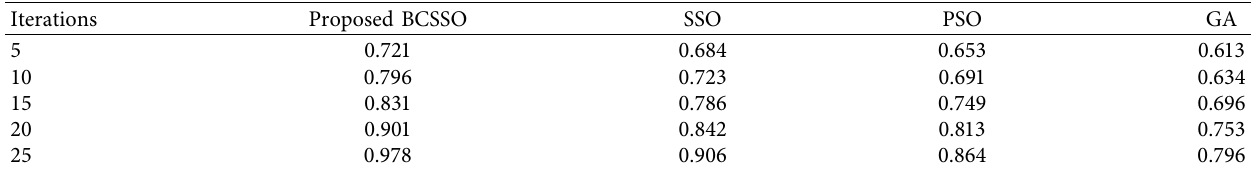
Table 1: Fitness vs. iteration